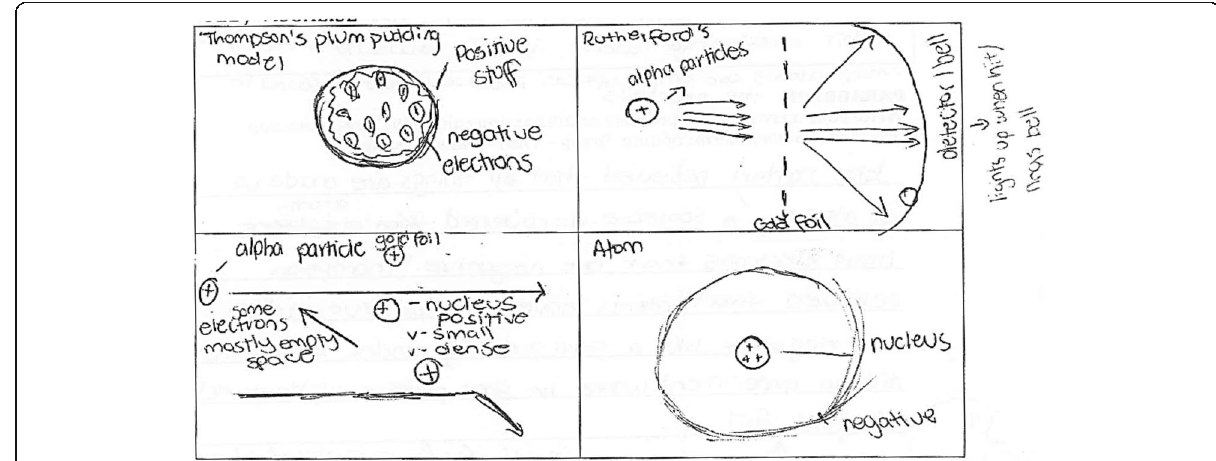
Fig. 2 Rachel ’ s visualisation explaining how we know about the structure of the